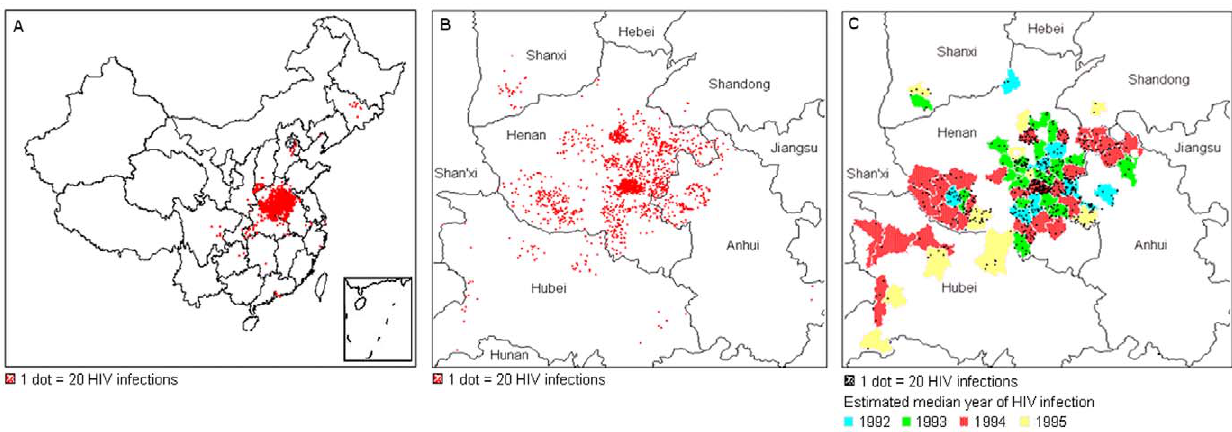
Figure 2. Distribution of HIV infection by region among former plasma donors (FPD) included in the analysis. Figure 2a: Map of the People’s Republic of China showing the geographic distribution of all 36110 HIV-infected FPDs included in this analysis by location. Each dot represents 20 people. Figure 2b: Close-up map of Henan Province and the surrounding province showing the geographic distribution of all HIV- infected FPDs included in this analysis from this region. Each dot represents 20 people. Figure 2c: Close-up map of Henan Province and the surrounding province showing the geographic distribution of only the 16038 HIV-infected FPDs included in this analysis from this region with a # 2 year plasma donation window. Estimated median peak year of HIV infection is indicated by county. Each dot represents 20 people.